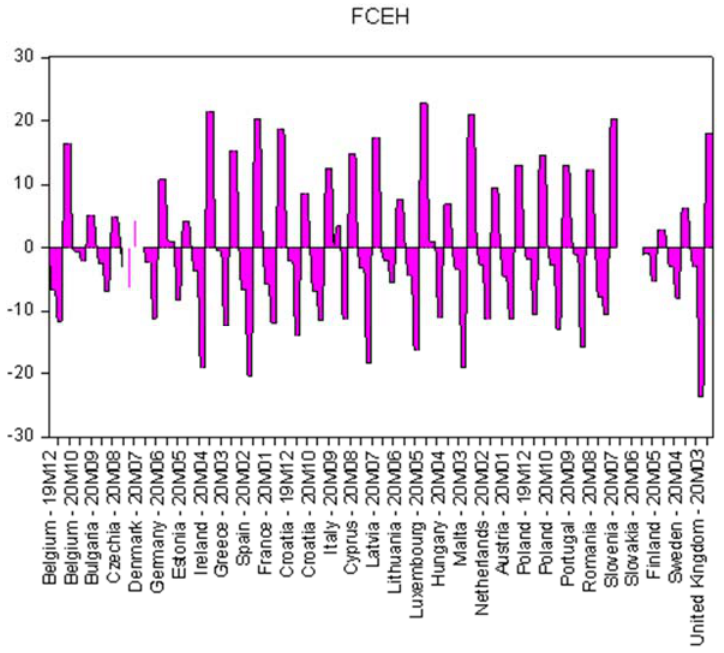
Figure 2. Evolution of the final consumption expenditure for households ( FCEH ) across the country sample. Note : Figures displayed after the symbol M indicate the number of the month in the calendar year.